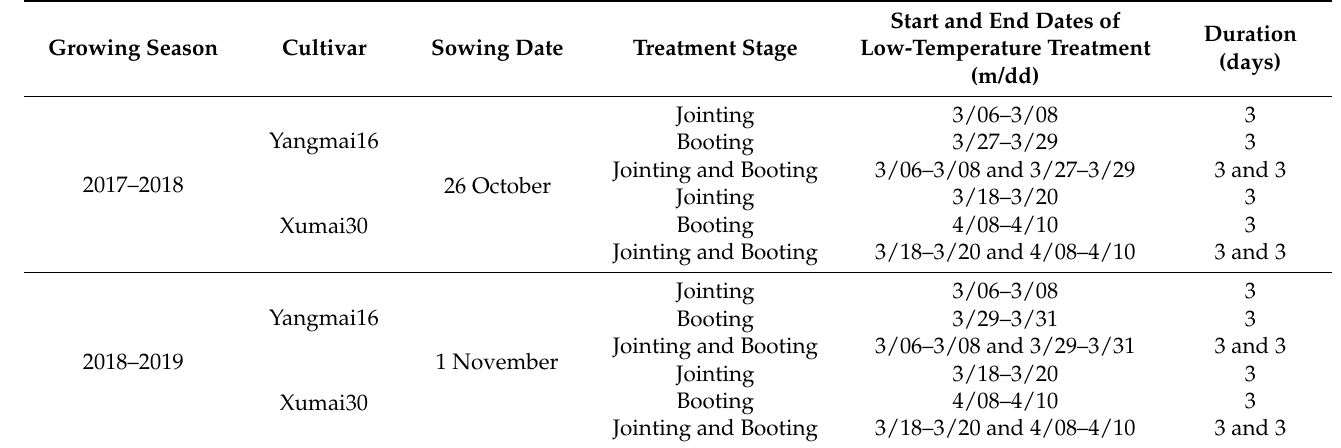
Table 1. Summary of the treatments.